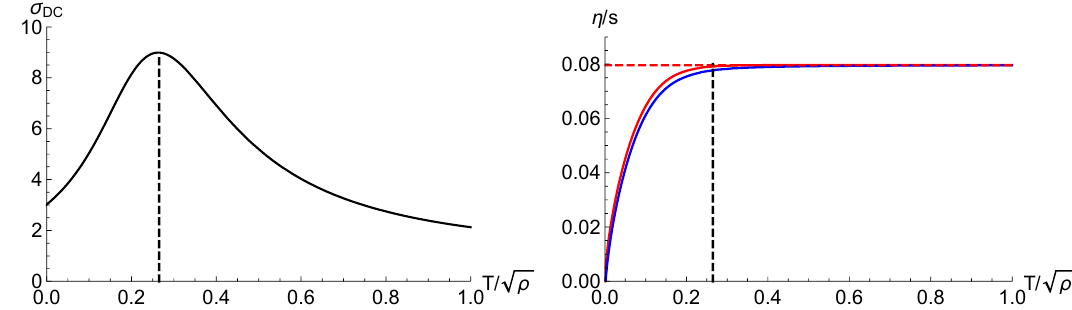
Figure 11 . DC conductivity and η/s as the function of the temperature. The black dashed line indicates the transition temperature. Left : K = − 1 / 8 and λ = 5 × 10 − 2 . Right : K = − 1 / 8 , λ = 0 (red solid line) and λ = 5 × 10 − 2 (blue solid